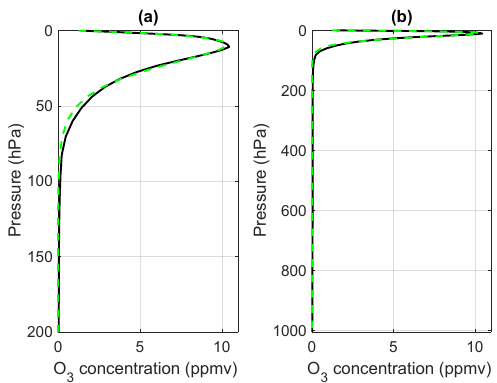
Figure 1. Ozone concentration (ppm) from the Aqua-Planet Ex- periment (black) and gamma distribution given by Eq. (1) (green dashes), as a function of pressure above 200hPa (a) and as a func- tion of pressure over the whole atmosphere (b)